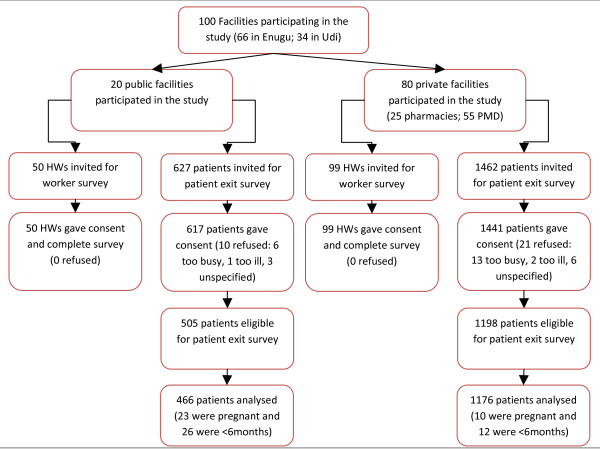
Study population.